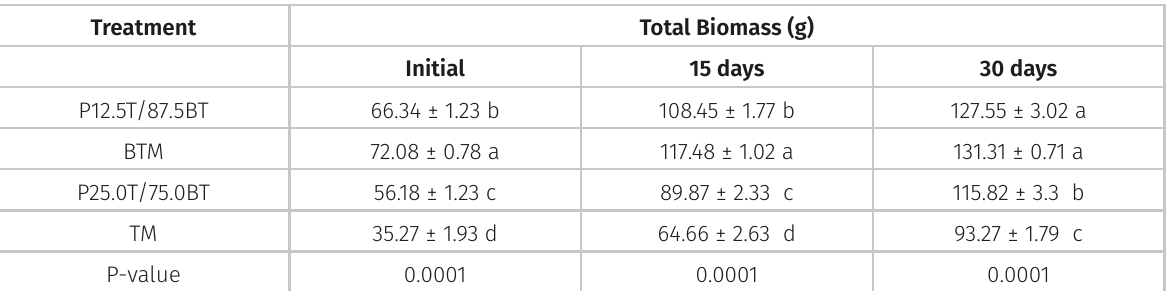
to P<0.05 by the Tukey